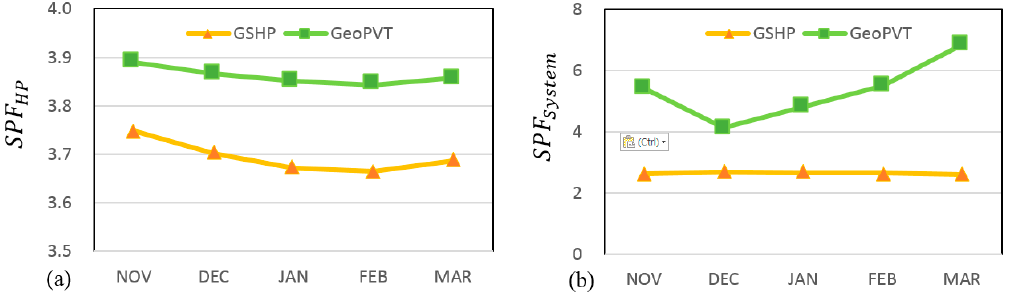
Figure 21. The result of SPF during daytime operation in heating season. ( a ) Heat pump; ( b ) system.